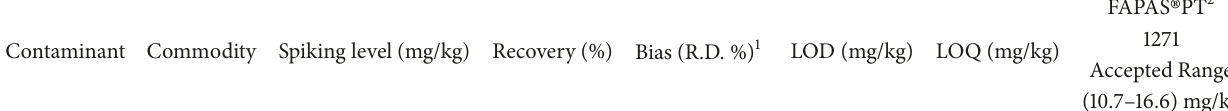
Table 1: Validation parameters for formaldehyde in dairy food.